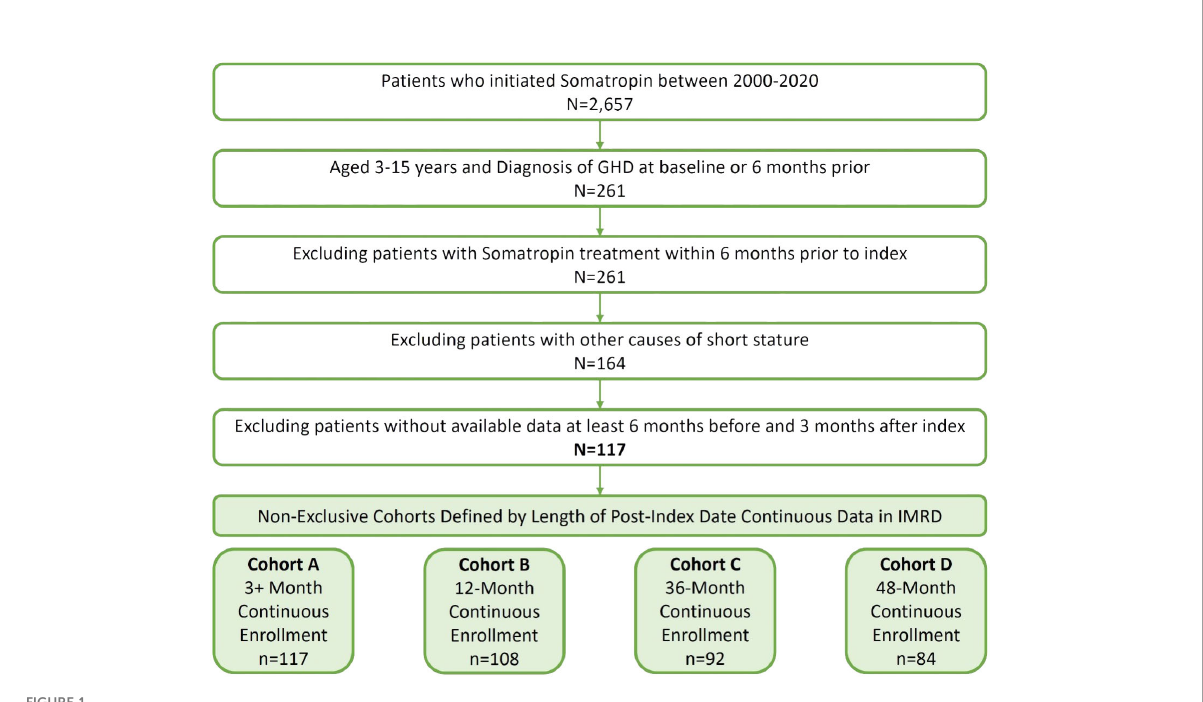
FIGURE 1 Cohort sample identi fi cation of children ( ≥ 3 and < 16 years) with pGHD treated with daily somatropin in the